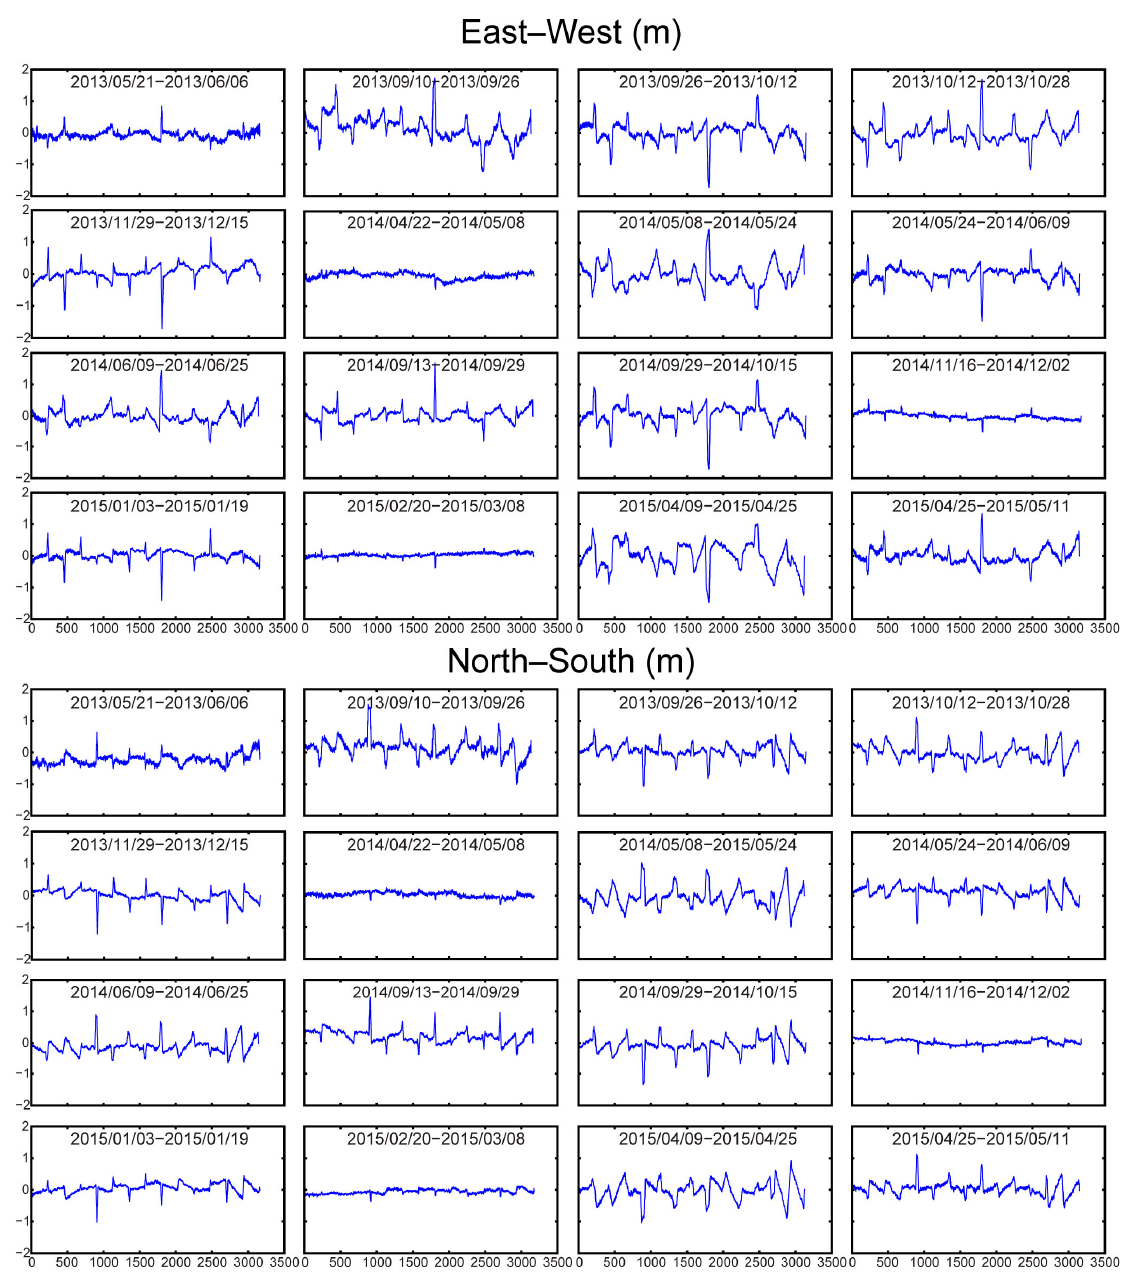
Figure A2. Patterns of the SA in E/W and N/S deformation fields. Clearly, patterns of these three pairs (22 April 2014–8 May 2014, 16 November 2014–2 December 2014, and 20 February 2015–8 March 2015) with much less variation are different from the ones of the rest image pairs.